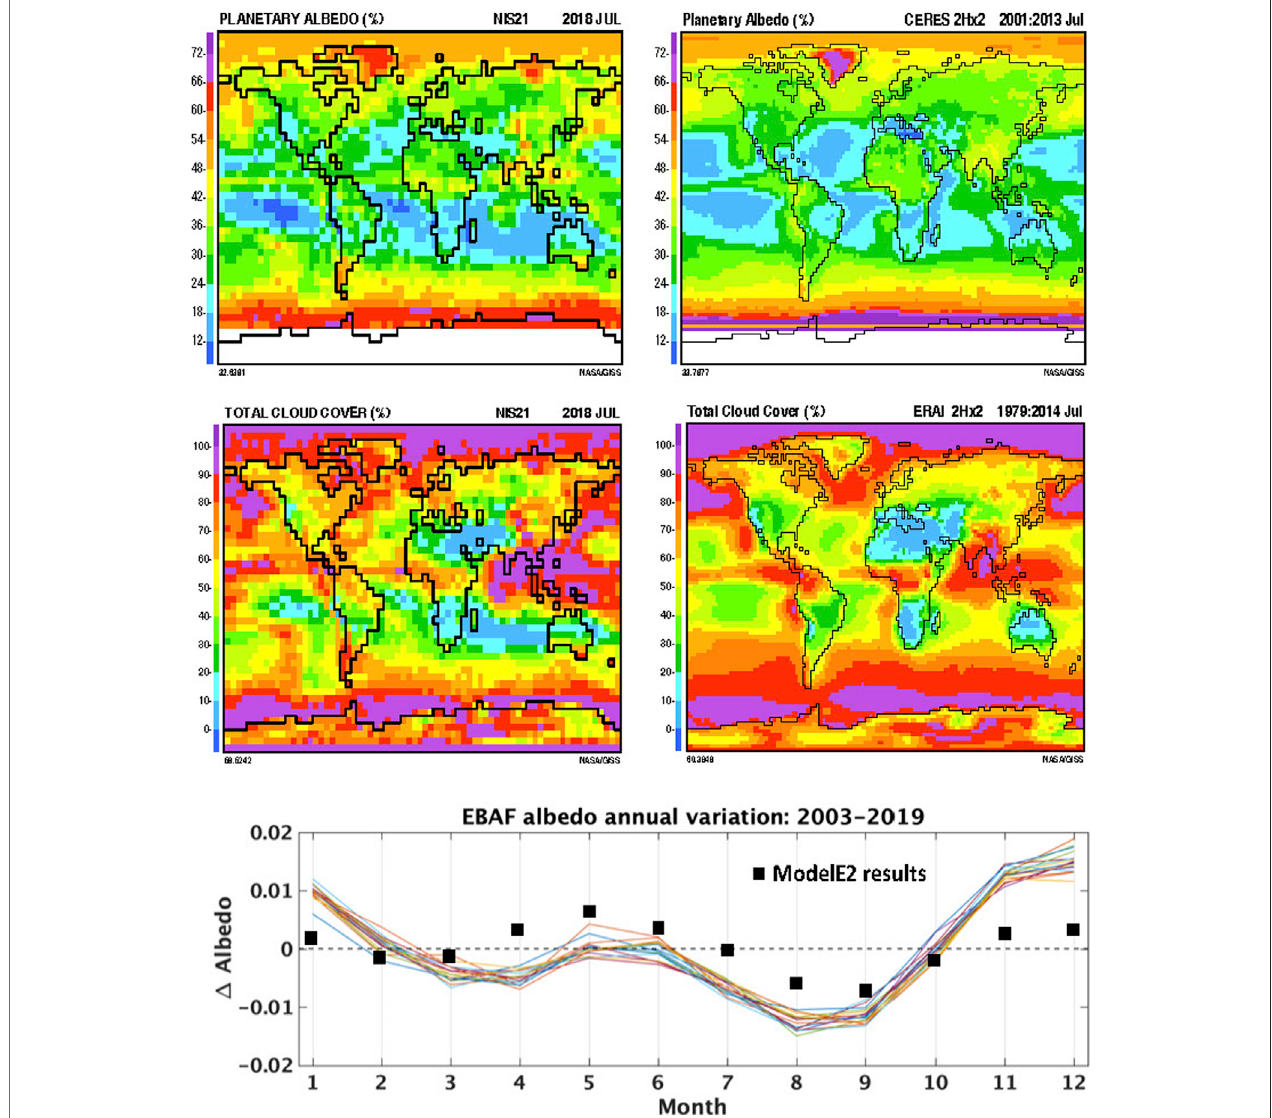
FIGURE1| ModelE24×5degreehorizontalresolutionmonthly-meanplanetaryalbedo (UpperLeft) andtotalcloudcover (MiddleLeft) computedforJuly2018. The corresponding observational counterparts are the CERES planetary albedo (Upper Right) on a 2 × 2.5 degree grid averaged over the years 2001 – 2013, and the ECMWF Re-Analysis-Interim (ERAI) total cloud cover (Middle Right) also on a 2 × 2.5 degree grid averaged over the years 1979 – 2014. Seasonal CERES EBAF planetary albedo (Bottom) for 2003 – 2019 (Loeb et al., 2009; 2018) with the ensemble annual mean subtracted. For comparison, the black squares depict the ModelE2 decadal-mean seasonal variability of the global planetary albedo for years 2000 – 2010 with the annual mean subtracted.